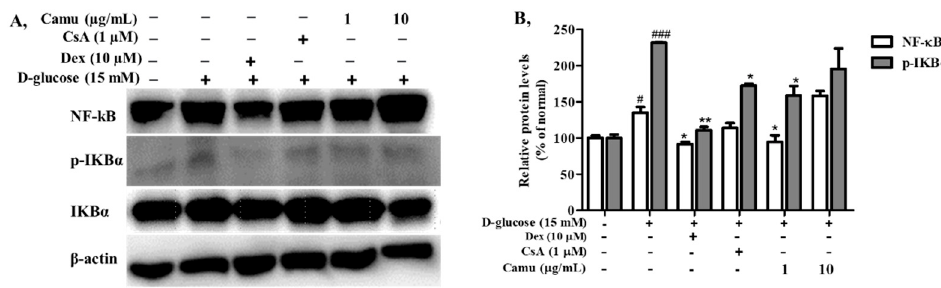
Figure 5. Effects of the camu-camu fruit on the NF- κ B signaling pathway in high glucose-stimulated HaCaT cells. ( A ) The expression of NF- κ B, IKB α and phosphorylation of IKB α were performed by Western blotting. Band intensities of NF- κ B and p-IKB α ( B ) were measured by densitometry and normalized; the percentage was calculated on the basis of the level of β -actin. Values are shown as the means ± SD of three independent experiments. # Significant differences between the untreated group and the high glucose-induced group (# p < 0.05; ### p < 0.001). * Significant differences